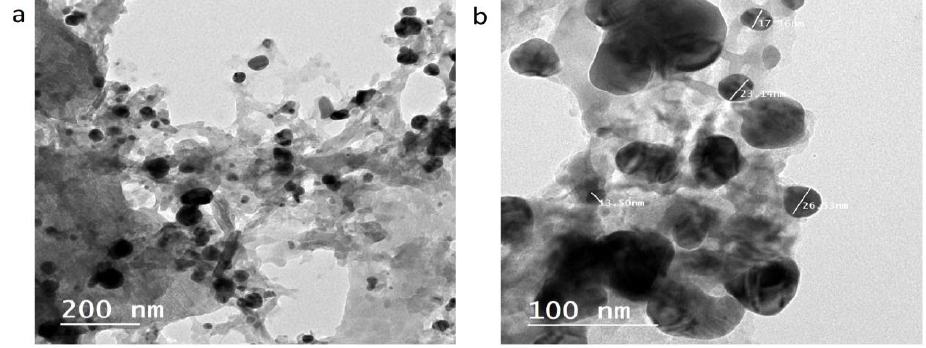
Figure 8. TEM images of H 31 /AgNPs5% composite at different magnifications: (a) 200 nm and (b) 100 nm.